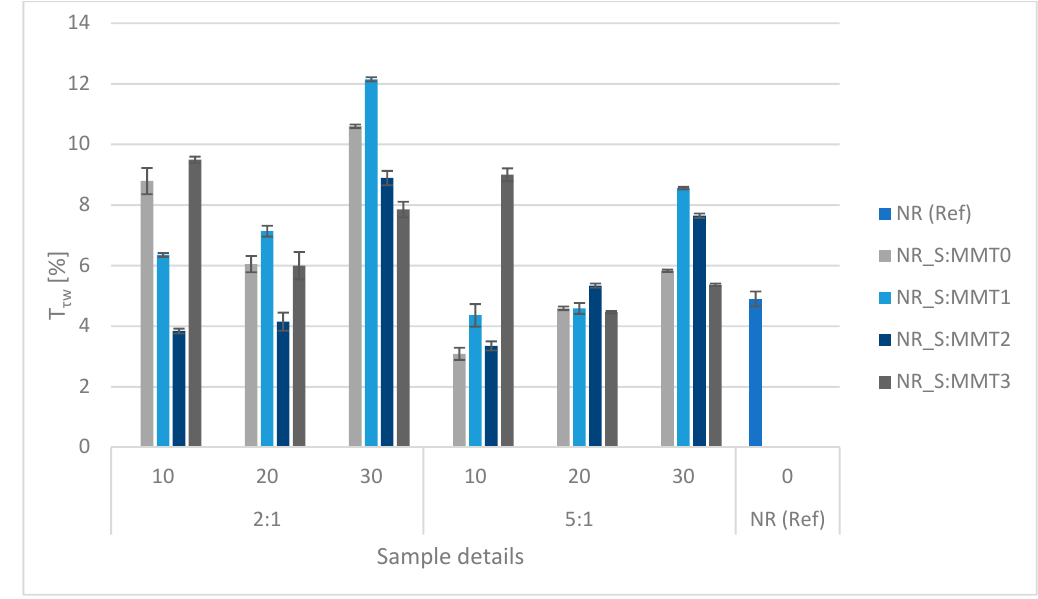
Figure 15. Influence of the type of biofiller and its amount on the damping properties of biocomposites.